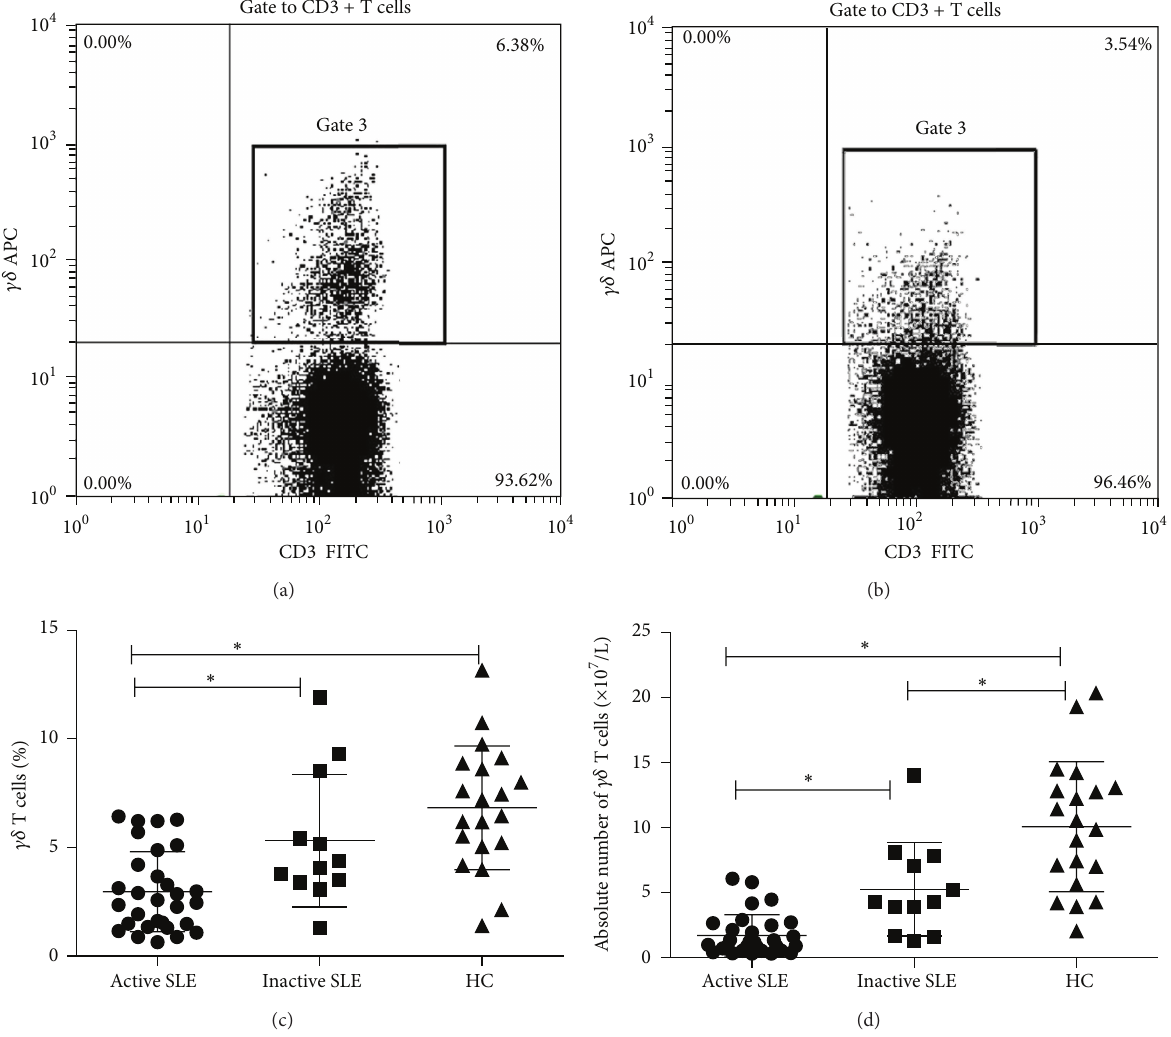
Figure 1: Reduction of 𝛾𝛿 T cells in peripheral blood of SLE patients. (a) and (b) Representative flow cytometric plot of CD3 + 𝛾𝛿 + T cells from one healthy control (HC) and one SLE patient, respectively. (c) Comparison of the percentage of peripheral 𝛾𝛿 T cells among active SLE patients, inactive SLE patients, and healthy controls. (d) Comparison of the absolute number of peripheral 𝛾𝛿 T cells among active SLE patients, inactive SLE patients, and healthy controls. ( ∗ 𝑃 < 0.01